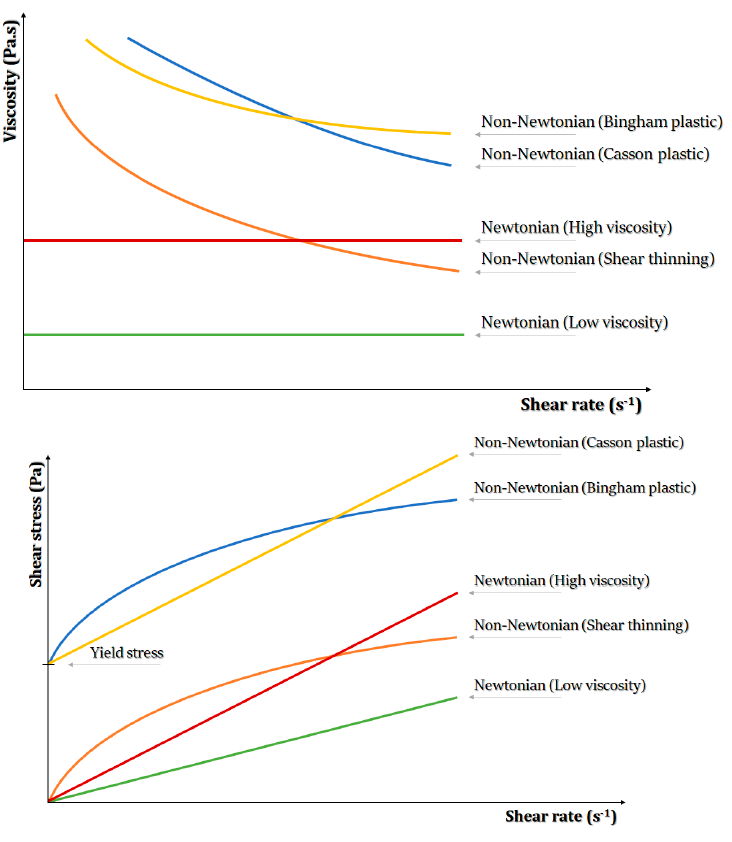
Figure 4. Plots of shear stress (or viscosity) versus shear rate representing flow curves of different rheological behaviors. The axes in this figure are displayed in linear scale.